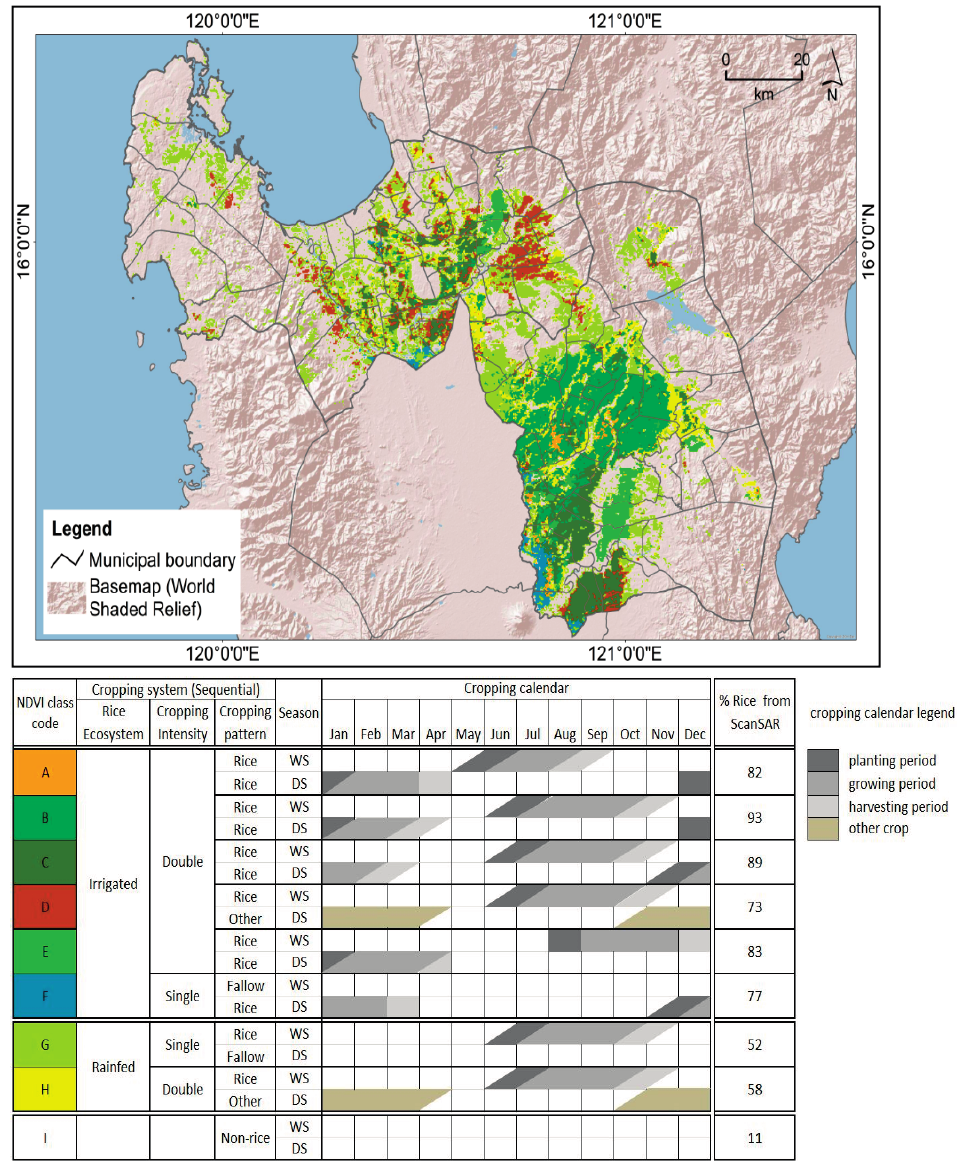
Figure 4. MODIS-derived rice cropping systems and characteristics